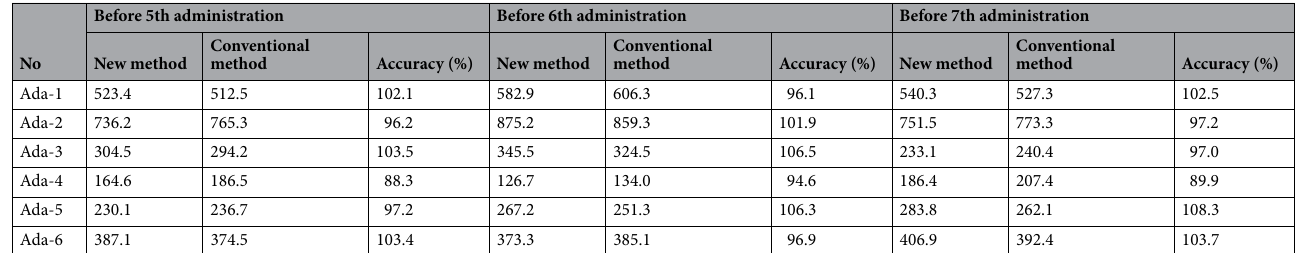
Table 4. The concentration of adalimumab in patients with RA before the fifth, sixth, and seventh administration of 40 mg